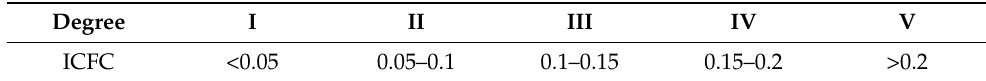
Table 1. ICFC classification